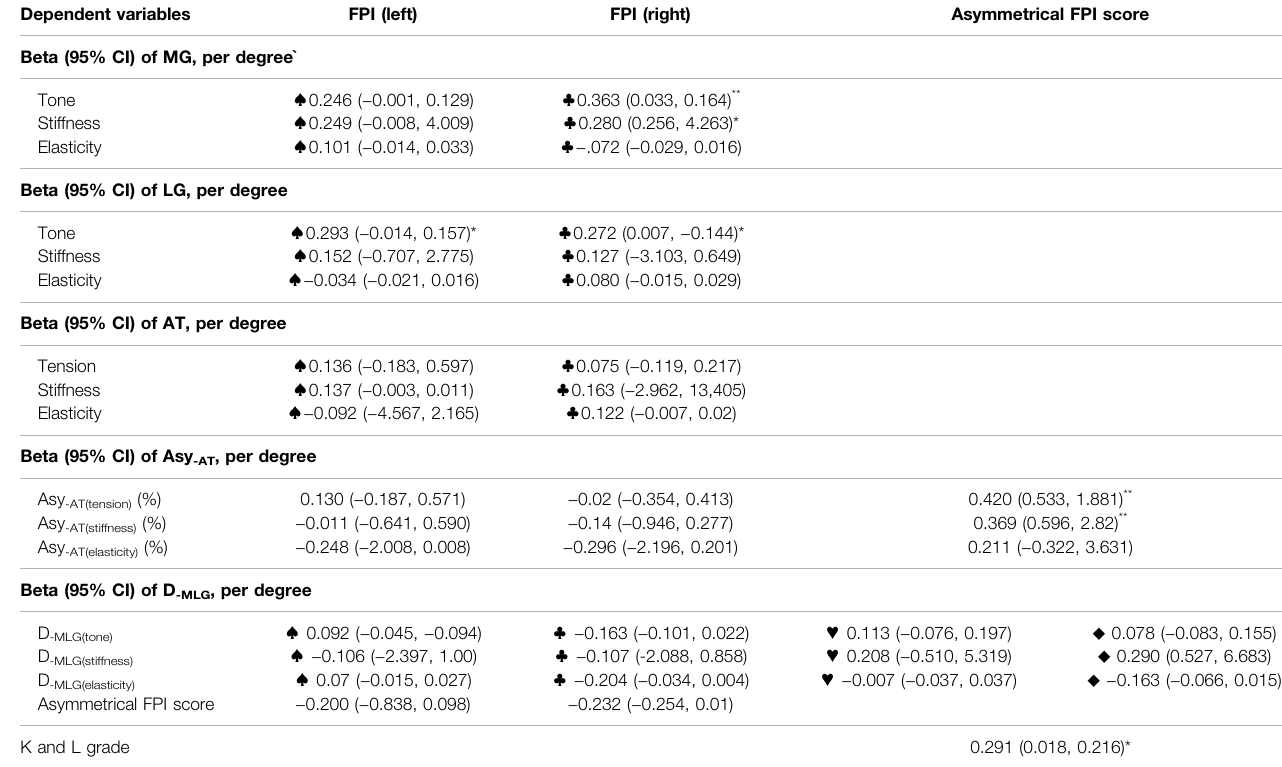
TABLE 4 | The association of FPI scores with GM and AT properties. Dependent variables FPI (left) FPI (right) Asymmetrical FPI